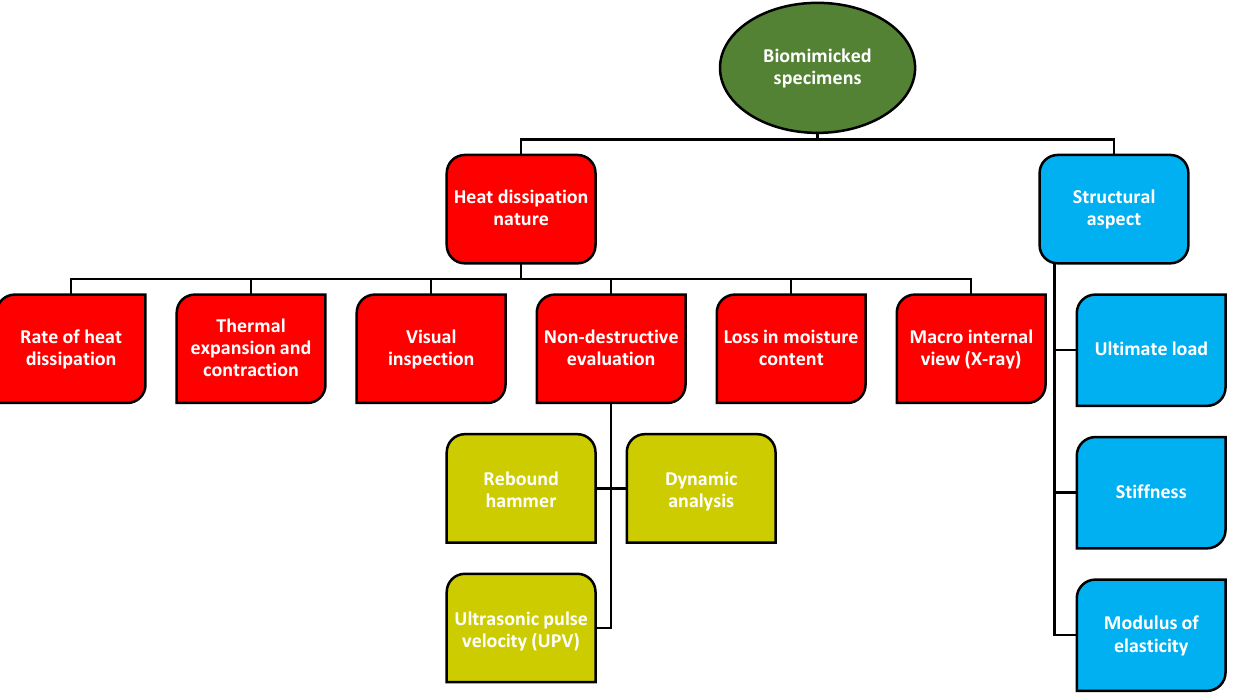
Figure 6. The schematic flow of the entire experimental procedure.